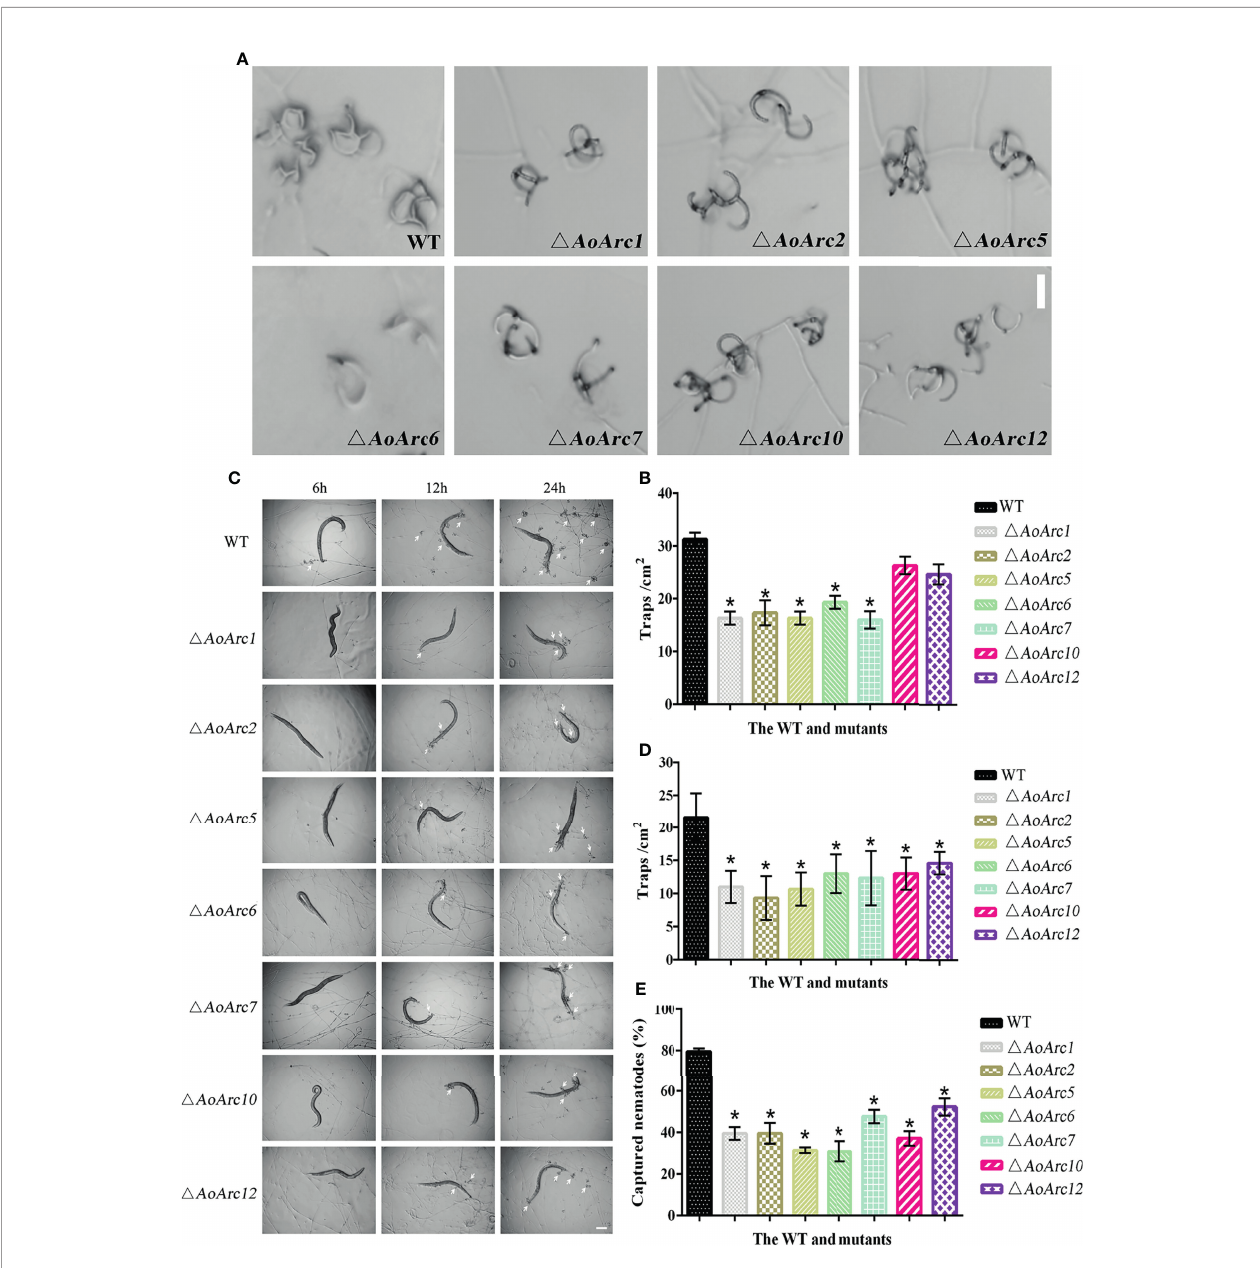
FIGURE 4 | Comparison of trap formation and nematocidal activity between the WT and mutants. (A) The formation of traps after 48 h of ammonia treatment (bar = 50 m m). (B) Statistics of the number of traps after 48 h of ammonia treatment. (C) Trap formation of fungal strains induced by nematodes at 6, 12, and 24 h. White arrows: traps. Bar: 50 m m. (D) The number of traps in the WT and mutant strains was compared at 24 h after nematode induction. (E) Comparison of captured nematodes by the WT and mutant strains at 24 h. The asterisk indicates a signi fi cant difference compared with the WT ( p <